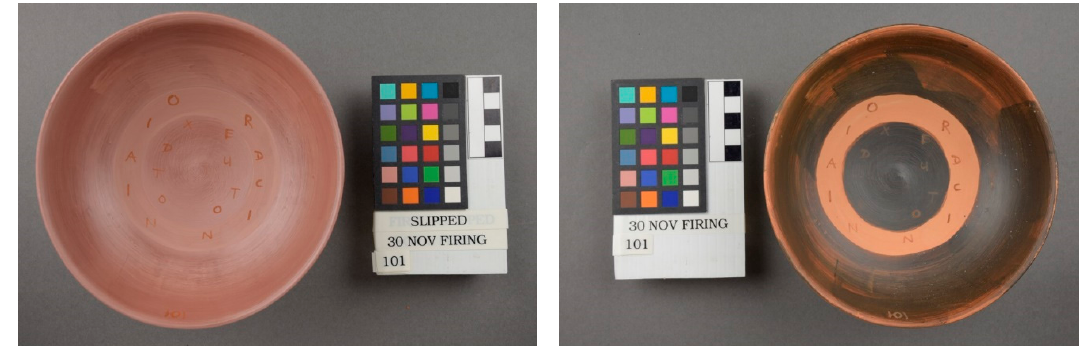
Figure 5. The fired wares produced in the November 2016 test firing. The black-figure plate was provided by Eleni Aloupi-Siotis of Thetis Authentics, Ltd., for test firing in our kiln.